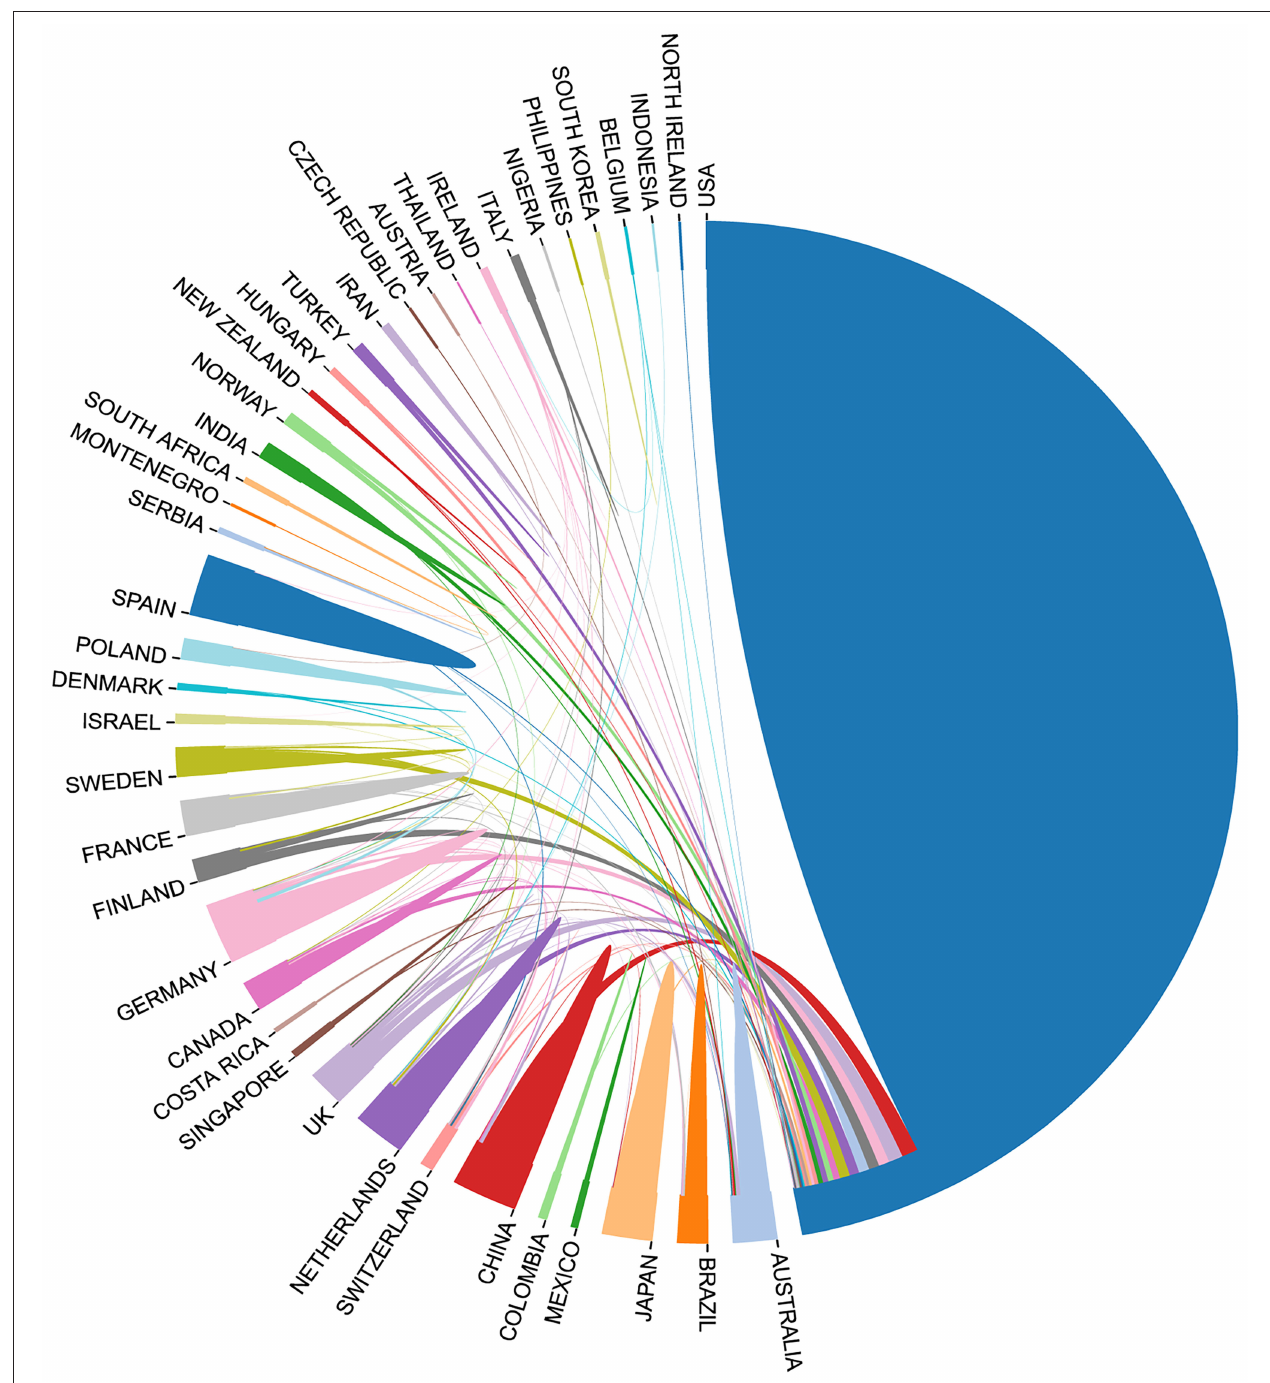
FIGURE 4 | Cooperation between contributed